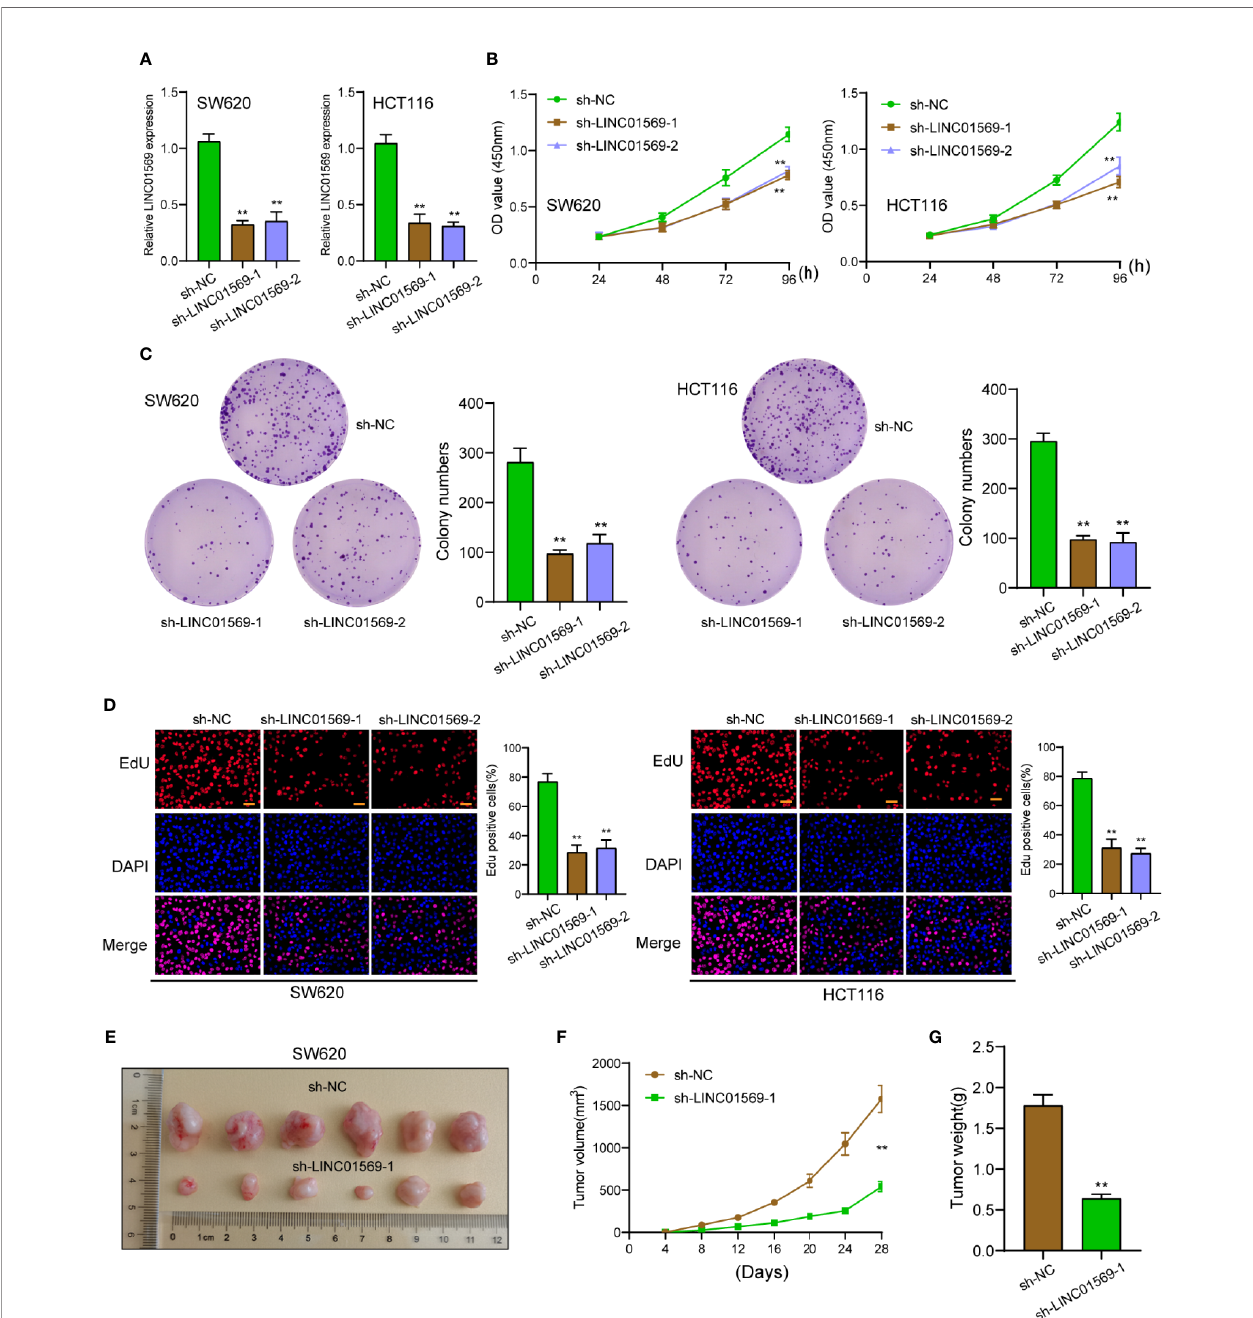
FIGURE 2 | LINC01569 promoted the proliferation of CRC cells. (A) qRT-PCR assay for LINC01569 expression in SW620 and HCT116 cells transfected with sh- LINC01569-1, sh-LINC01569-2, or sh-NC cells at 48 h post-transfection. (B, C) Cell viability of LINC01569-silenced CRC cells was measured by CCK-8 assay and colony-generating assay. (D) EdU assay for the functional exploration of LINC01569 knockdown in CRC cells. (E) Representative photographs of tumor xenografts obtained from the sh-LINC01569-1 as well as sh-NC groups. (F) The growth curves for the tumor xenografts. (G) The weight of the tumor xenografts. **P <